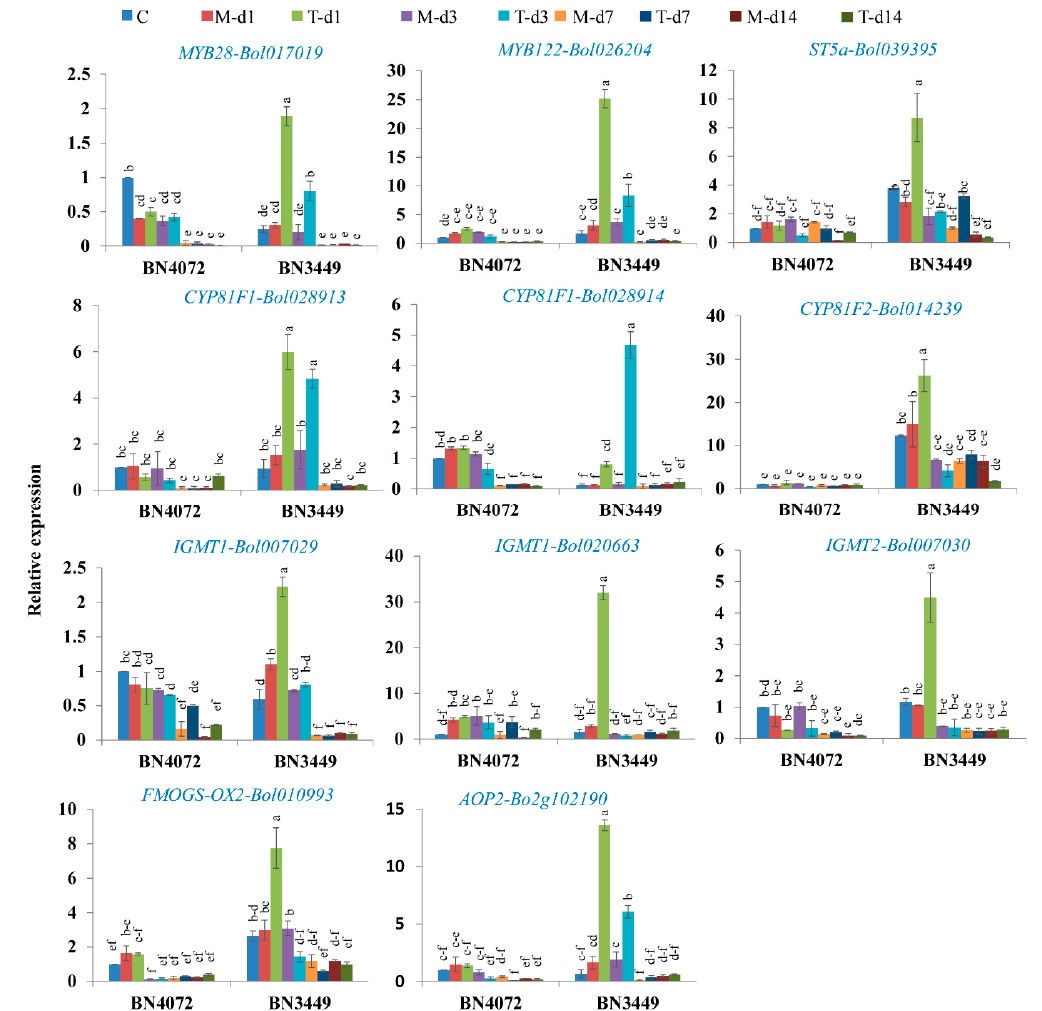
Figure 4. Upregulated genes of transcription factor related and glucosinolate biosynthesis genes in Ringspot S line BN3449 of cabbage. C: Control; M-d1: Mock day 1; T-d1: Treated day 1; M-d3: Mock day 3; T-d3: Treated day 3; M-d7: Mock day 7; T-d7: Treated day 7; M-d14: Mock day 14; T-d14: Treated day14. The means of three biological replicates are shown. Vertical bars indicate standard deviation. Different letters indicate statistically significant differences between R and S lines, and treatment interactions. R: Resistant; S: